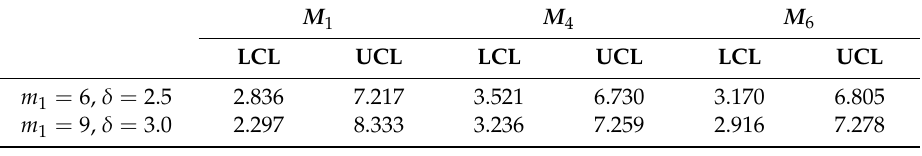
Table 5. Control limits of the median charts based on M 1 , M 4 and M 6 for the concrete data. M 1 M 4 M 6 LCL UCL LCL UCL LCL UCL m 1 = 6, δ = 2.5 2.836 7.217 3.521 6.730 3.170 6.805 m 1 = 9, δ = 3.0 2.297 8.333 3.236 7.259 2.916 7.278